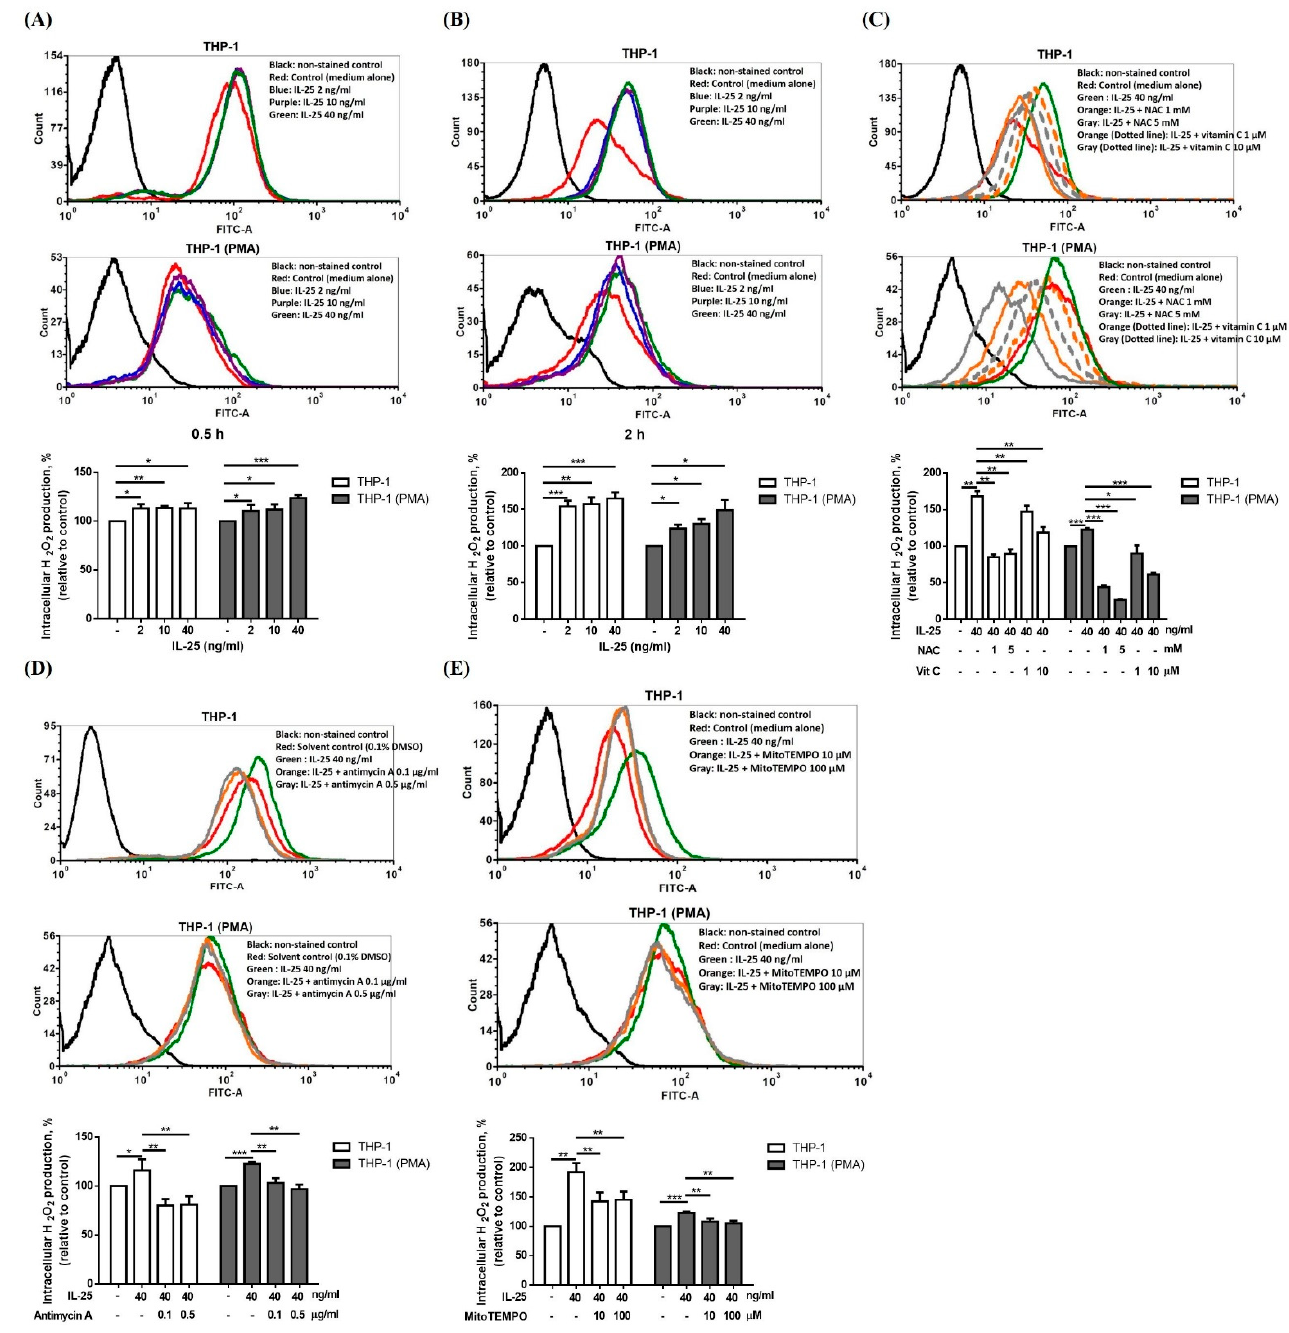
Figure 1. IL-25 alone could induce intracellular ROS level and suppressed by NAC, vitamin C, antimycin A and MitoTEMPO. ( A – E ), representative histograms of cell counts (counts) vs. DCF fluorescence (FITC-A) (above), and the mean fluorescence intensity (MFI) of DCF is expressed as percentage relative to control cells (below). THP-1 cells (white bar) and THP-1 derived macrophages (gray bar) treated with medium alone or IL-25 (2, 10 and 40 ng/mL) was for 0.5 h ( A ) or 2 h ( B ). ( C ) Cells were treated with medium alone or IL-25 (40 ng/mL) present pretreatment with NAC (1 and 5 mM) or vitamin C (1 and 10 μ M) for 0.5 h. After pretreatment with solvent control (0.1% DMSO) or antimycin A (0.1 and 0.5 μ g/mL) ( D ), or medium alone or MitoTEMPO (10 and 100 μ M) ( E ) for 0.5 h followed by IL-25 treatment, the ROS level was measurement. * p < 0.05, ** p < 0.01, and *** p < 0.001; n = 3, means ±